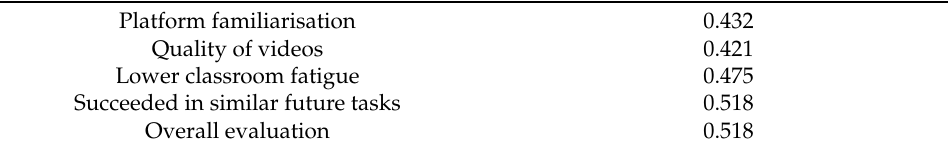
Table 1. Variables highly correlated with the module’s enjoyability.